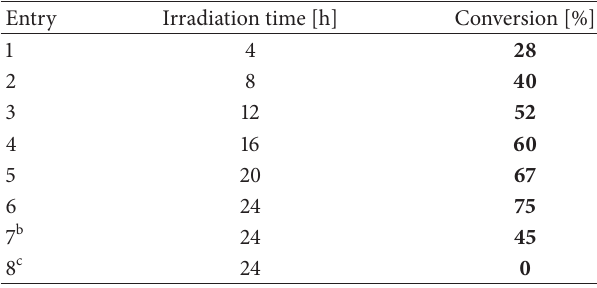
Table 1: Direct cross-coupling of benzene with 4-chlorotoluene under UV light irradiation a (see Scheme 3 and Figure